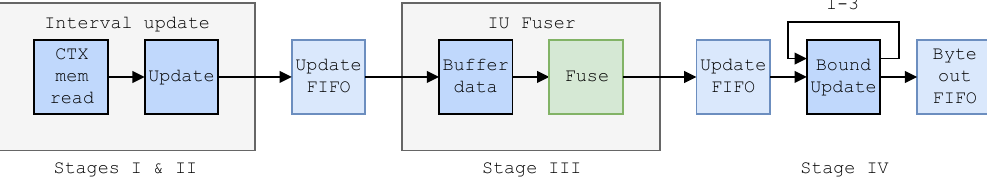
Figure 9. MQ-coder architecture. The interval updates are fused when possible, having less bound updates which could stall the